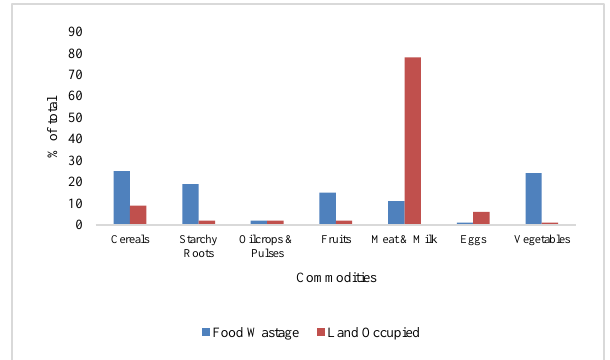
Figure 6: Land occupied by each commodity of food wastage (FAO, 2011a)